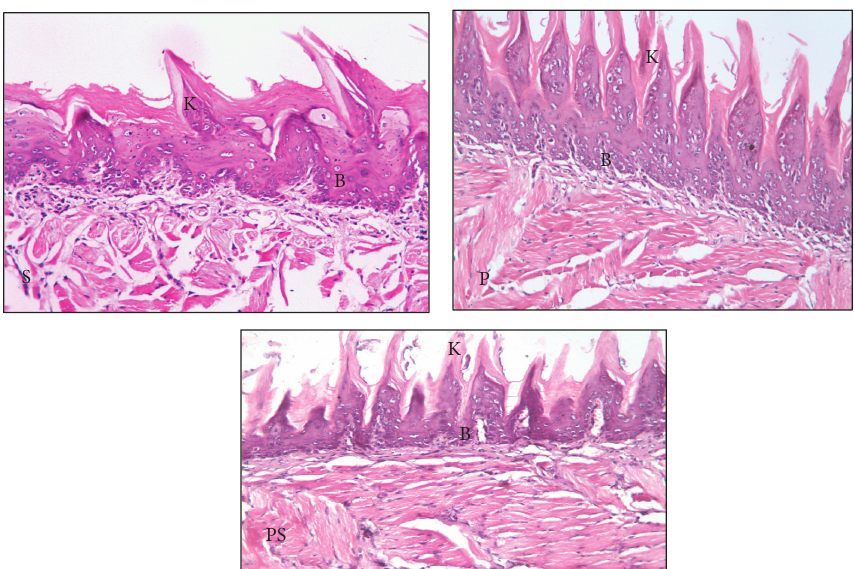
Figure 4: Photomicrographs of the dorsal surface of the tongue of the treated groups [(S) irradiation + MSCs, (P) irradiation + PRP, (PS) irradiation + MSCs + PRP] at 3 days following radiation showing slight alteration in basal cell architecture (B) and preserved keratin tips over the lingual papillae (K) (H&E, × 200).